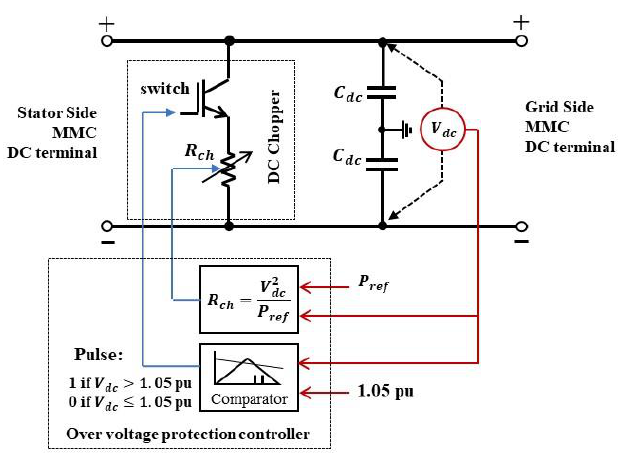
Figure 12. DC link Circuit model.